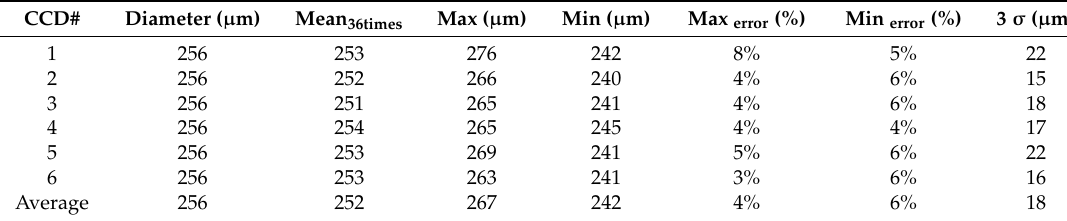
Table 4. Results for Detected Protrusion on Green Film.